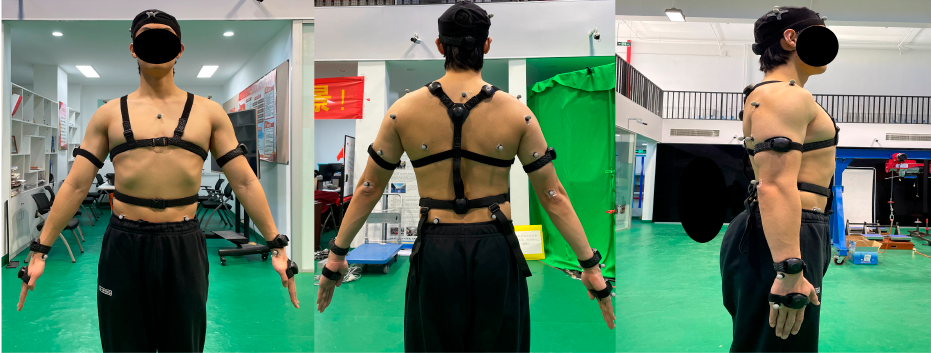
Figure 1. Placements of 11 IMUs and 25 reflective markers on a participant.